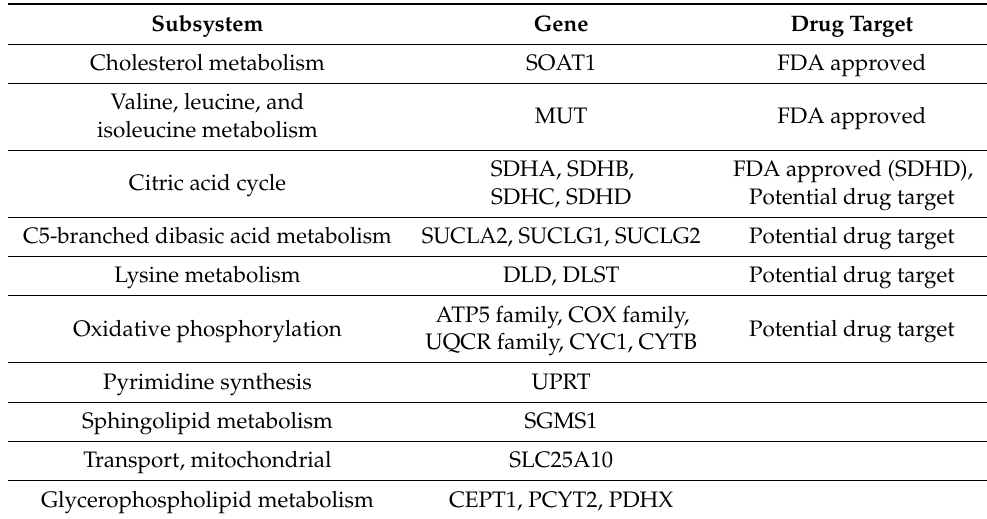
Table 1. List of genes identified as important from in silico gene knockout analysis and mapped to their subsystems and known drug target information from Human Protein Atlas (HPA). Drug target information for the genes is provided in the last column (FDA-approved drugs or potential drug target) using the information from HPA [15]. Subsystem Gene Drug Target Cholesterol metabolism SOAT1 FDA approved Valine, leucine, and MUT FDA approved isoleucine metabolism SDHA, SDHB, FDA approved (SDHD), Citric acid cycle SDHC, SDHD Potential drug target C5-branched dibasic acid metabolism SUCLA2, SUCLG1, SUCLG2 Potential drug